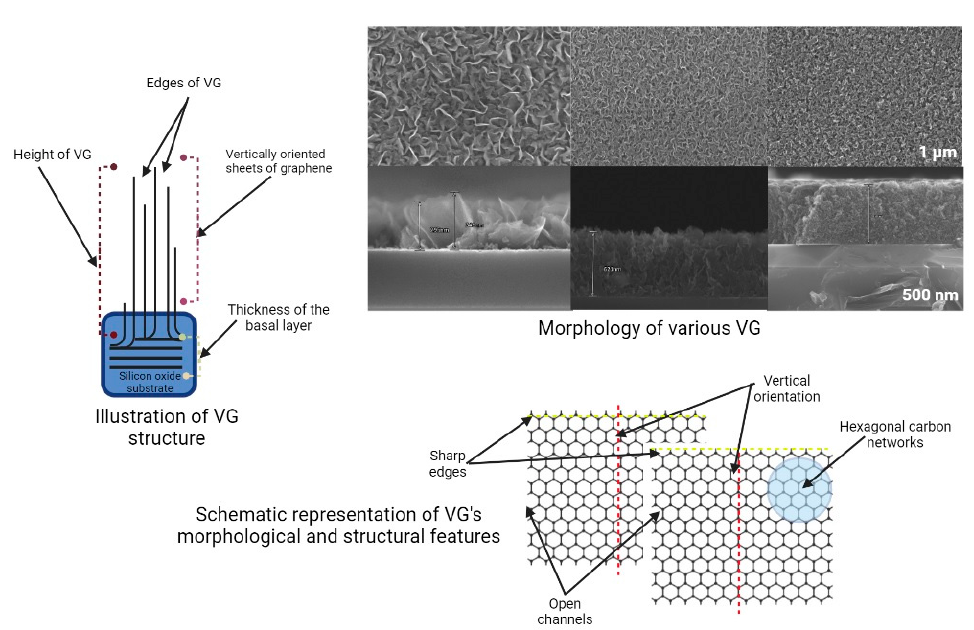
Figure 2. Schematic representation of VG: structure (the way VG is growing), morphology (SEM images of various VG), and the most important morphological and structural features.